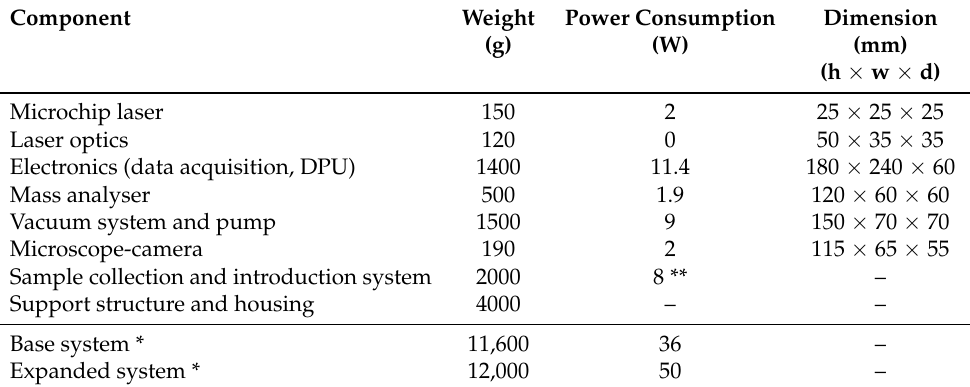
Table 1. Components of the ORIGIN instrument for flight on